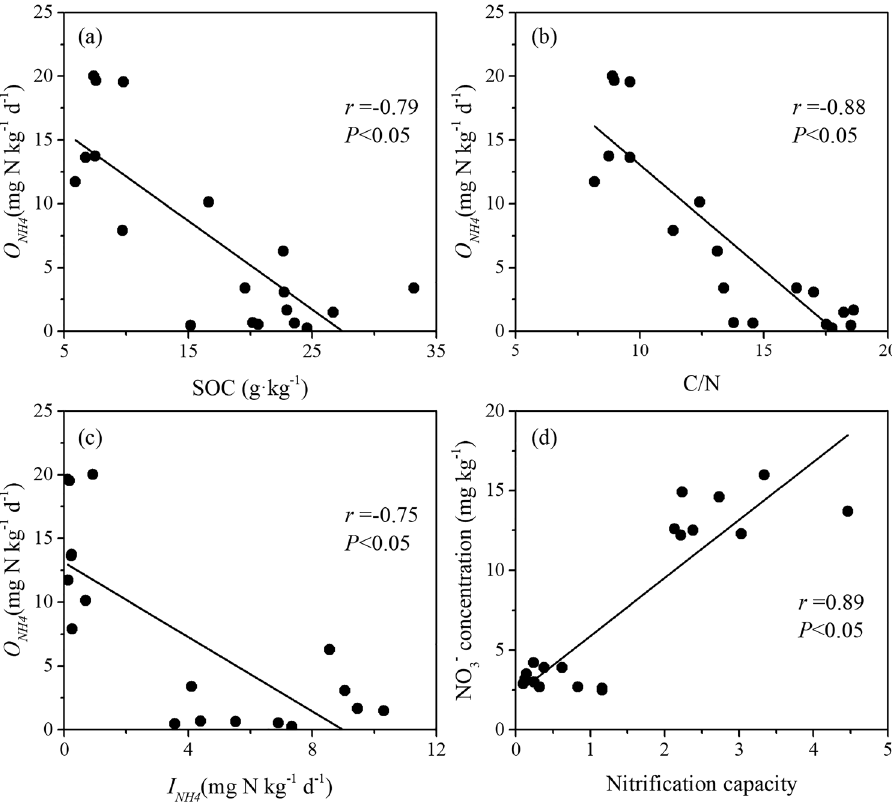
Figure 5. Relationships between soil gross nitrification rates and SOC content ( a ), C/N ratio ( b ) and gross NH 4 + immobilization rates ( c ), and between nitrification capacity and NO 3 − concentration ( d ). Nitrification capacity: ratio of O NH4 to M N